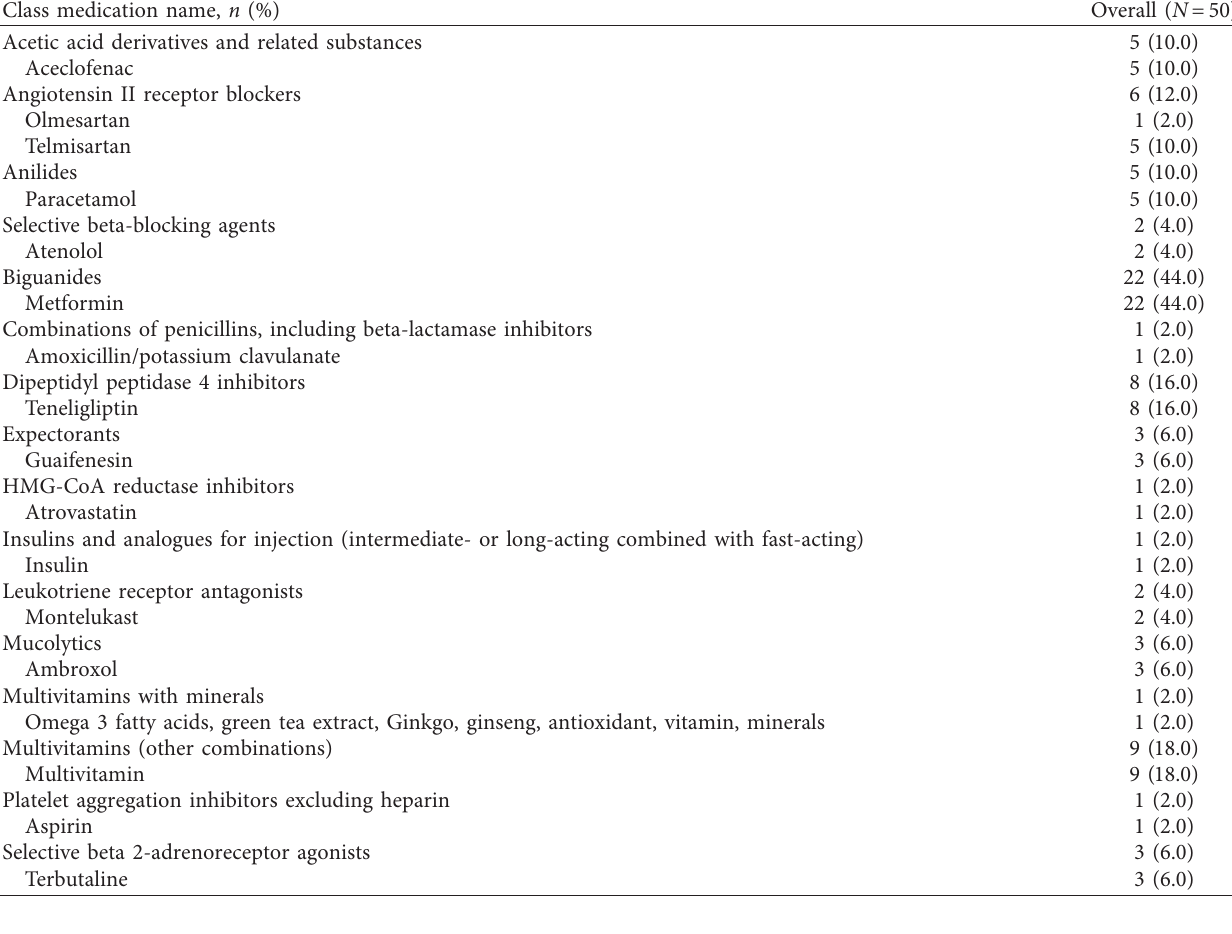
Table 3: Summary of concomitant medication (safety population) ∗